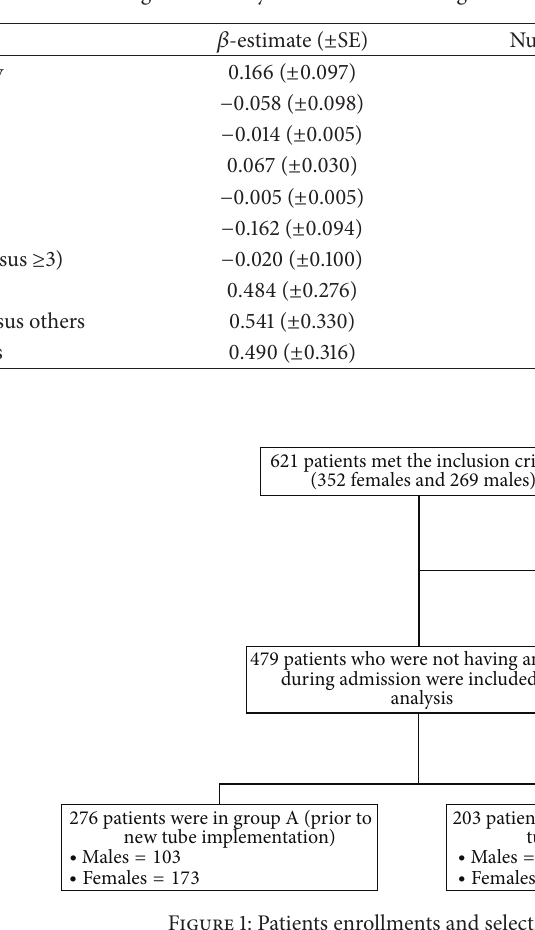
Table 2: Multilinear regression analysis: factors influencing the drop of hemoglobin in hospitalized patients.